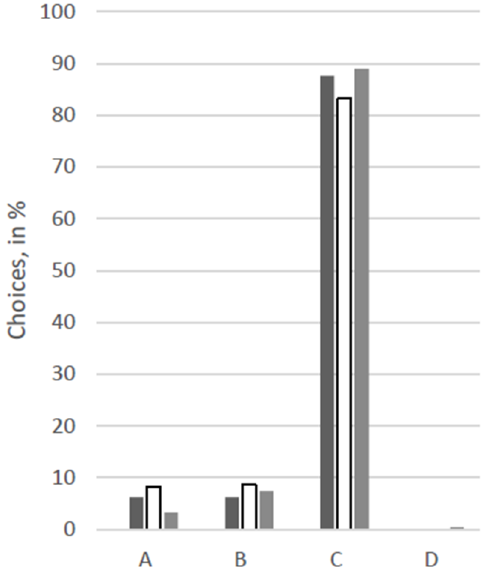
Figure 6. Answers from the scenario “6-months-old human” in %. Legend: black: human medicine group; white: control group; grey: veterinary medicine group; A: Euthanasia tablet, B: Sedation tablet, C: Potentially curative tablet, D: No treatment .